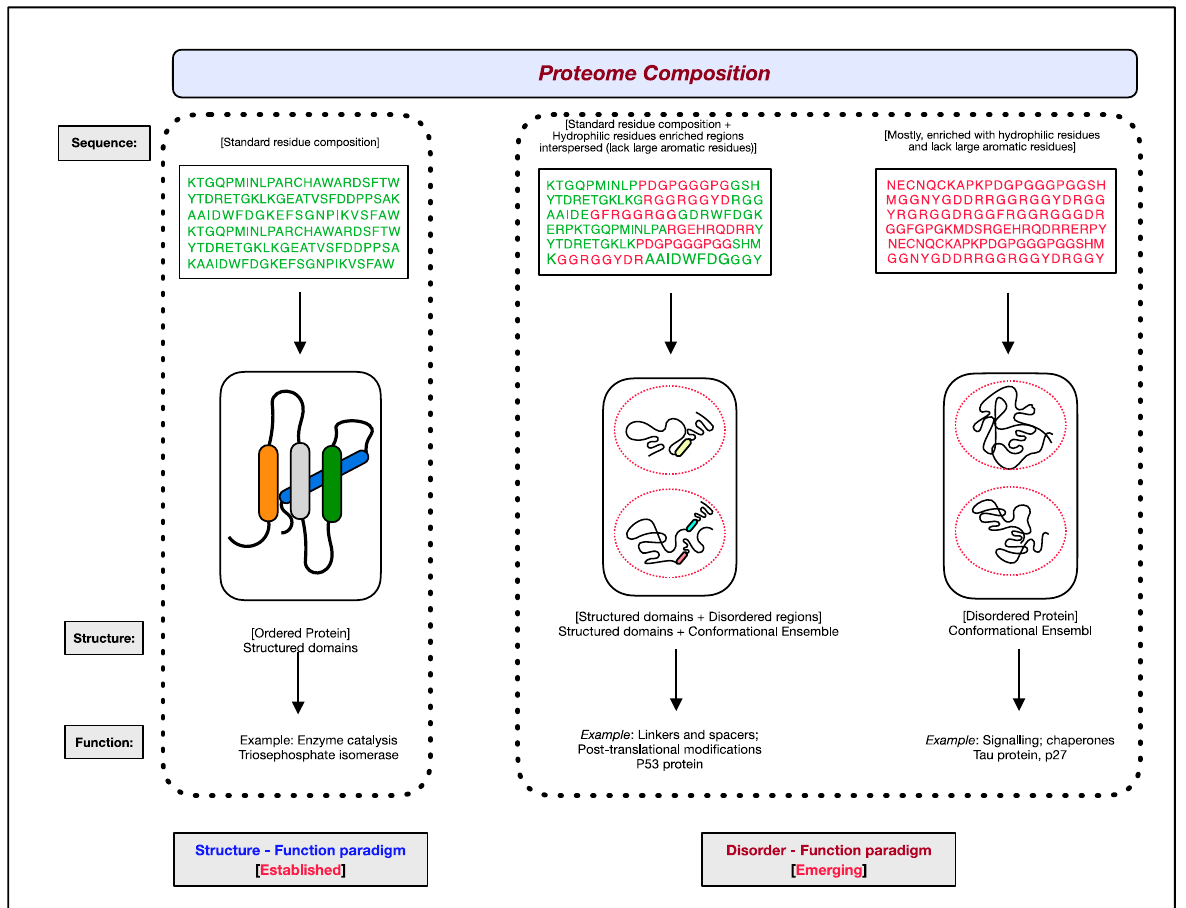
Figure 1. The two paradigms of protein structure and function. According to the well-established ‘structure–function paradigm’, a three-dimensional native structure under physiological conditions is vital for a protein to perform its biological function (for example, enzyme-catalyzed reactions). The more recent ‘disorder–function paradigm’ states that a protein can carry out its biological function without attaining a 3-D stable folded structure under physiological conditions (for example, protein binding to other cellular molecules). For representative purpose, residues coding for ordered/globular domains are shown in ‘green’ color, and residues coding for disordered proteins/segments are shown in ‘red’. At the proteome level, the structured domains and intrinsically disordered regions (IDRs) are two functional building blocks of proteins.